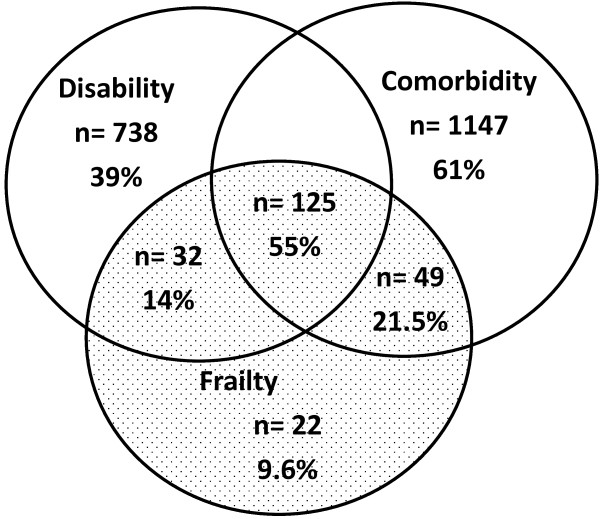
Interrelationship between frailty (≥3 criteria), disability (≥1 ADL), and comorbidity (≥3 diseases) in the study population. Venn diagram.